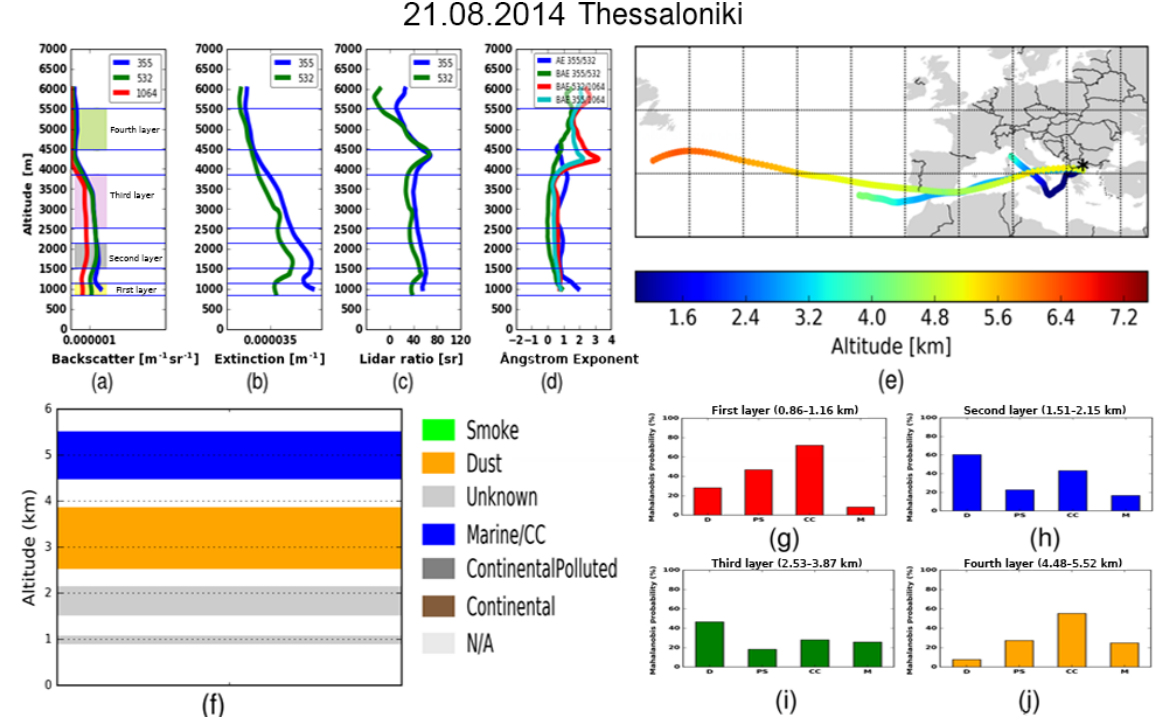
Figure 3. Vertical profiles of aerosol optical properties for Thessaloniki on 21 August 2014. (a) Backscatter coefficient profiles at 355, 532 and 1064nm, (b) extinction coefficient profiles at 387 and 607nm, (c) lidar ratio, (d) Ångström exponent, (e) 5-day backward trajectories arriving at Thessaloniki at each detected layer height, (f) aerosol main layers typed by NATALI, and (g–j) EARLINET Mahalanobis distance- based typing algorithm probability for each detected layer (different from the normalized